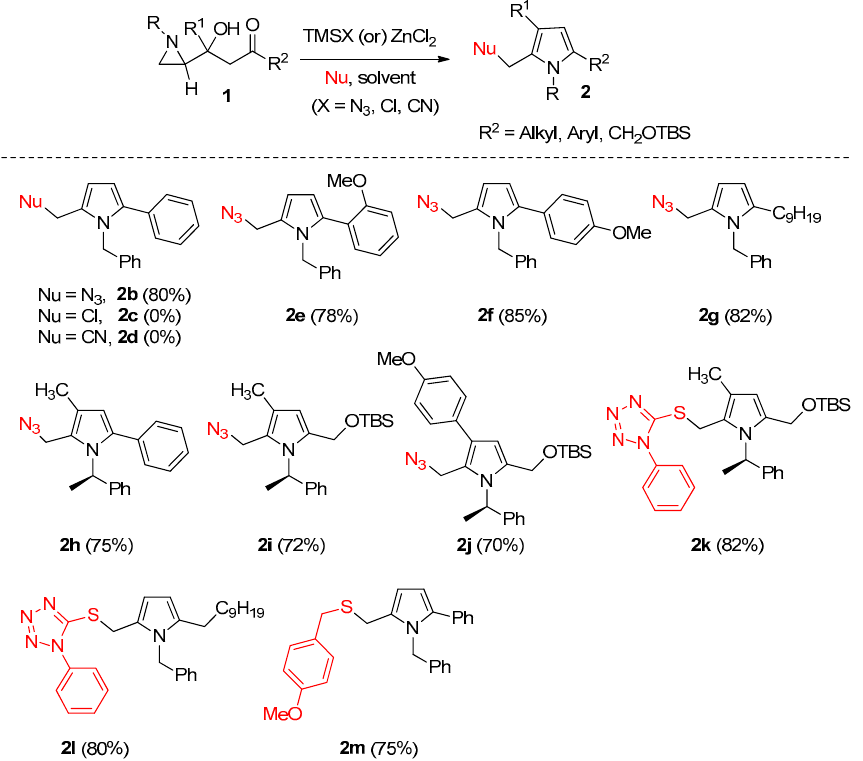
Scheme 2. Representative scheme and various examples of multi-substituted pyrroles ( 2 ) from sub- stituted aziridines ( 1 ).